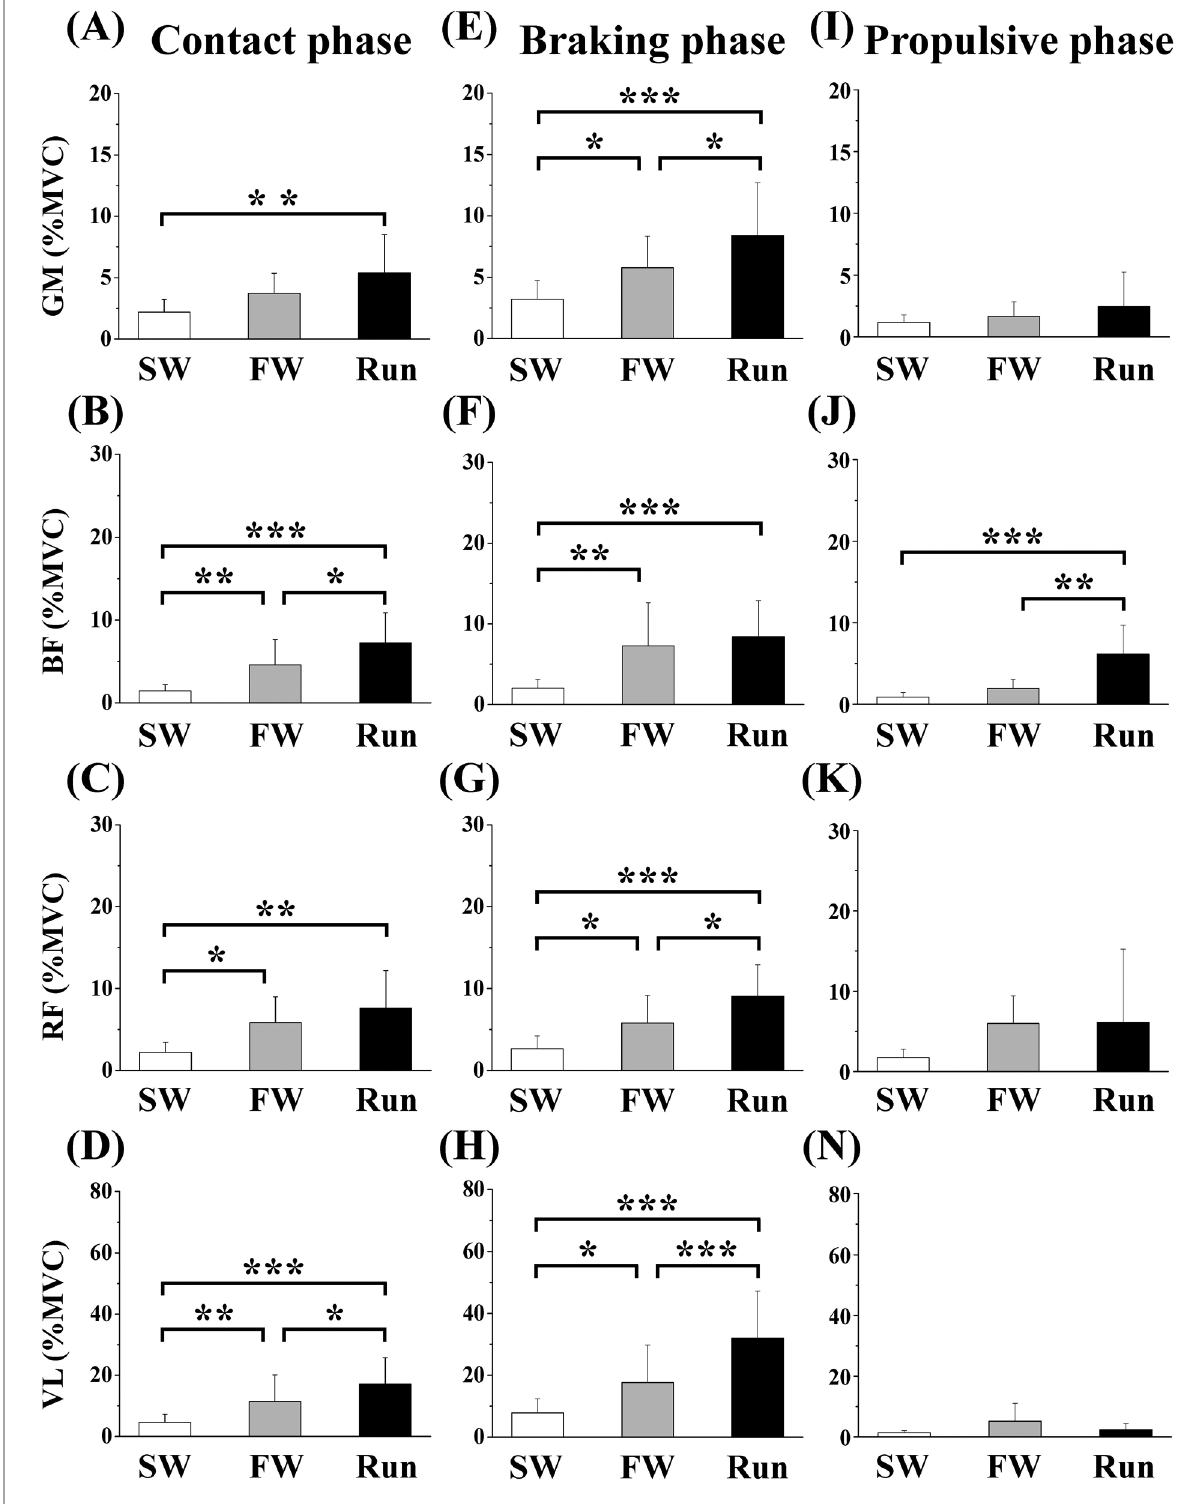
FIGURE 5 Averaged surface electromyography (aEMG) of femoral muscles during the contact ( A — D ), braking ( E — F ) and propulsive ( I — N ) phases. Values are means±SD. Signi fi cant difference between trials (* p <0.05, ** p <0.01, *** p <0.001). SW; Slow walk trial. FW; Fast walk trial. Run; Run trial. GM; Gluteus maximus, BF; Biceps femoris, RF; Rectus femoris, VL; Vastus